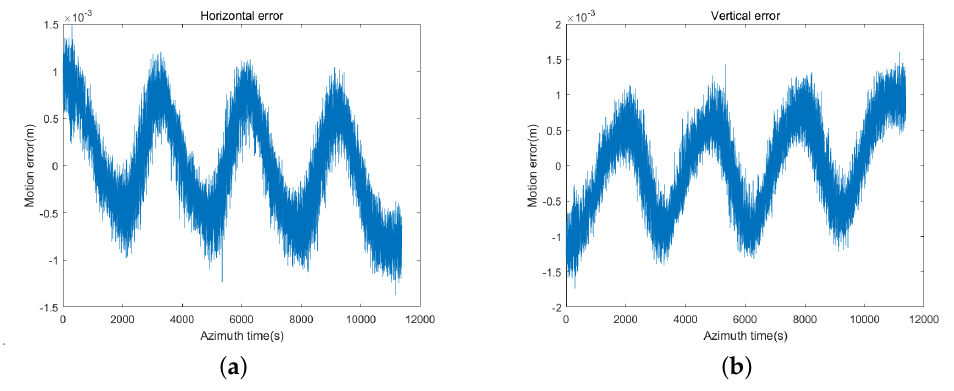
Figure 8. Estimationerror. ( a ) Horizontal error; ( b ) vertical error.